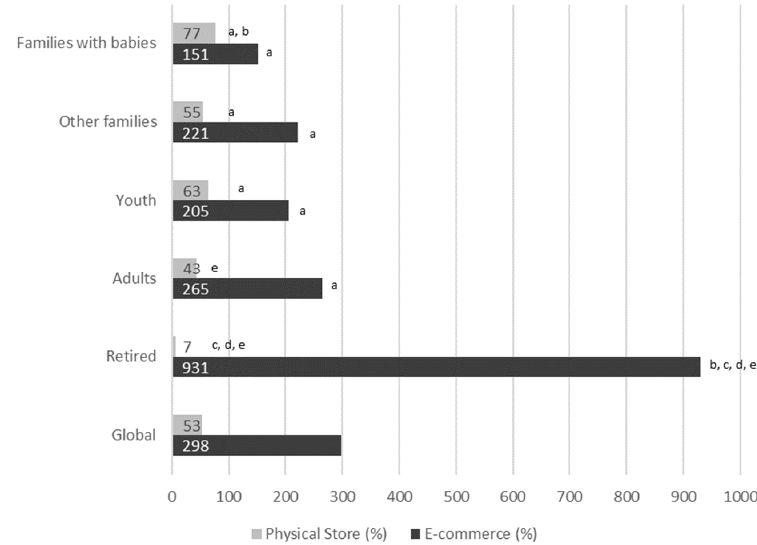
Figure 3. Relative increment in purchases of fish, seafood, and fish products in Spain, from 2019 to 2020, during the period March to June, according to loyalty card holder category and type of retailing. 11% of loyalty card holders are unclassified. In all cases, differences between e-commerce and physical store are statistically significant ( p < 0.005). Comparative between the type of customers within the same group (E-commerce or Physical store); a, Significant differences compared to el- derly; b, Significant differences compared to adults; c, Significant differences compared to youth; d, Significant differences compared to other families; e, Significant differences compared to families with babies.